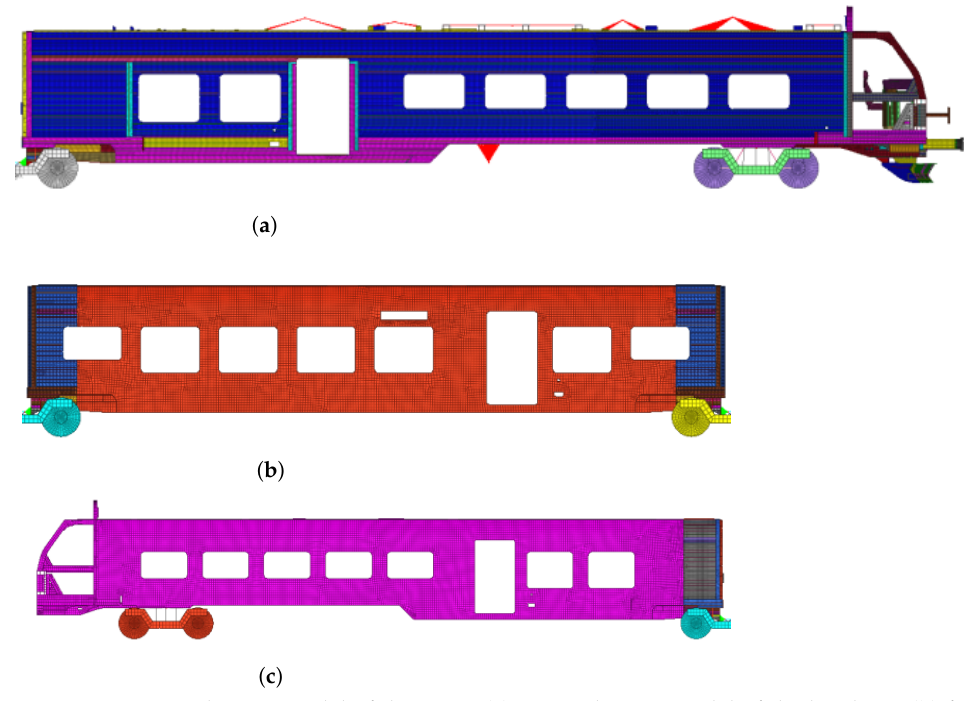
Figure 17. Finite element model of the train: ( a ) Finite element model of the head car; ( b ) finite element model of intermediate vehicle; ( c ) finite element model of the tail train. The cowcatcher is modeled using shell elements, while the bolted connection to the front end is simulated using beam elements. This is shown in Figure 18.